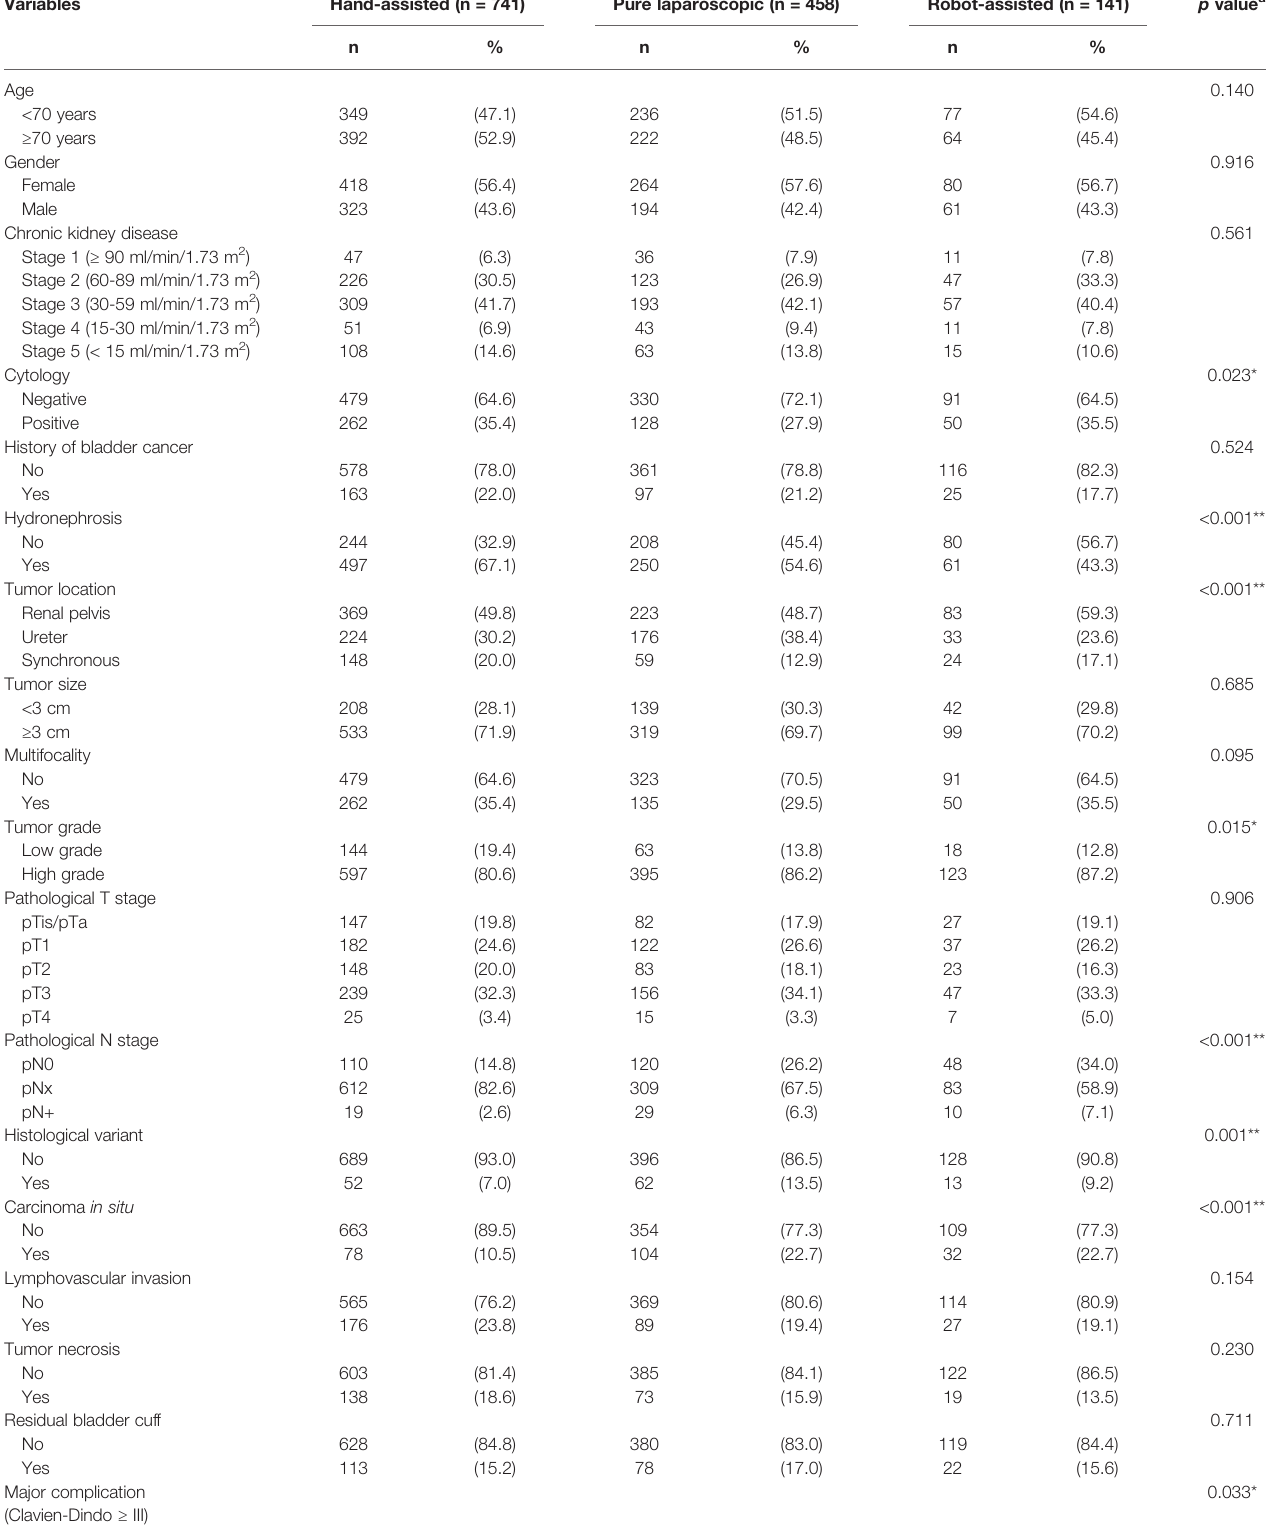
TABLE 1 | Clinicopathological data of UTUC patients receiving minimally invasive nephroureterectomy.